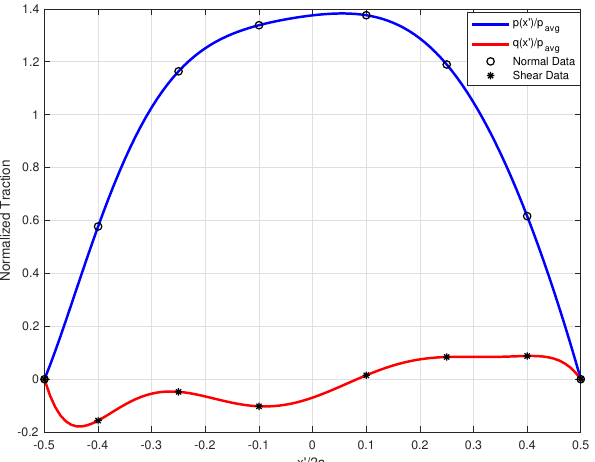
Figure 8. Example normal and shear contact traction fields from Bauer et al. [32]. Data points from test 1, load #2 of [32] curve-fit using 7th order polynomial functions to provide continuous expressions for boundary